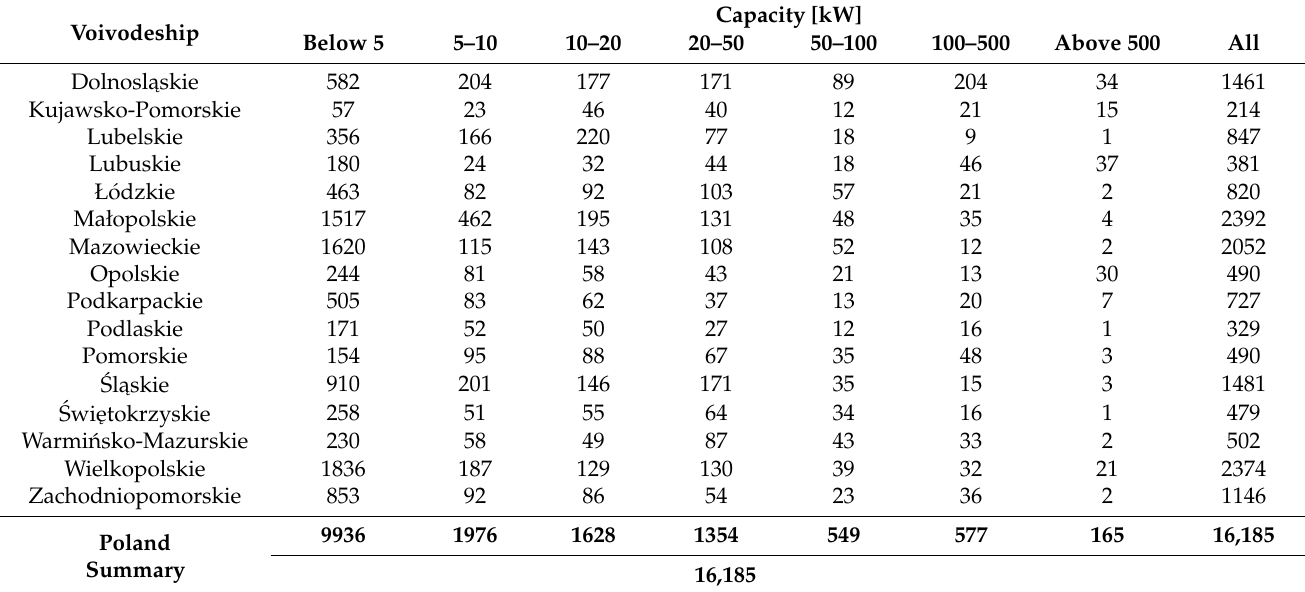
Table 5. Potential of SHPs in Poland (own